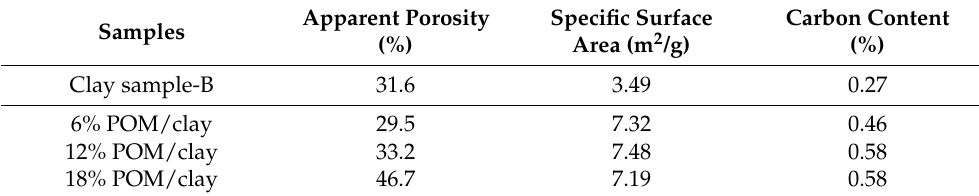
Table 6. Apparent porosity, specific surface area, and carbon content of POM/clay ceramic.